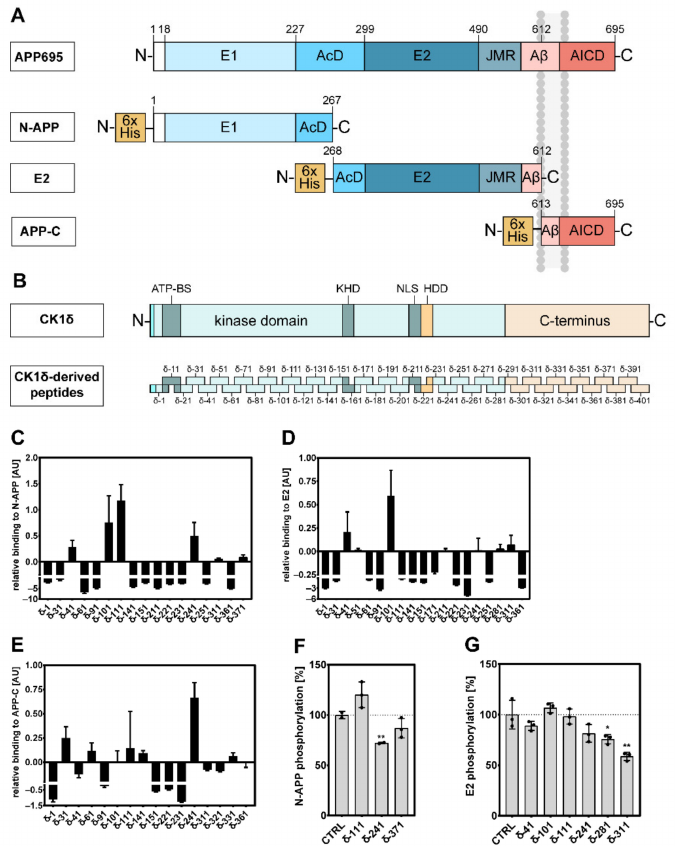
Figure 1. CK1 δ -derived peptides interact with APP695 fragments N-APP, E2, and APP-C and inhibit phosphorylation of N-APP and E2. ( A ) Domain structure of APP695 and the subsequently used protein fragments N-APP, E2, and APP- C [22]. ( B ) Domain structure of CK1 δ and localization of CK1 δ -derived peptides within in the full-length protein sequence. ( C,D,E ) Detection of CK1 δ -derived peptides specifically binding to APP695 fragments N-APP, E2, and APP-C was performed by ELISA ( n = 3). Specific binding to wells coated with APP695 fragments is demonstrated relative to unspecific binding to uncoated wells. ( F,G ) Effects of CK1 δ -derived peptides on CK1 δ -mediated phosphorylation of APP695 fragments N-APP and E2 were determined by performing in vitro kinase assays in the absence (DMSO; CTRL) or presence of 20 µ M of the indicated CK1 δ -derived peptides using GST-CK1 δ as kinase ( n = 3). Statistical analysis was performed using one-tailed t -test shown as * for p ≤ 0.05 or ** for p ≤ 0.01. AcD: acidic domain; AICD: APP intracellular domain; APP: amyloid precursor protein; ATP-BS: ATP binding site; AU: arbitrary units; CTRL: control; E1/E2: ectodomain 1/2; HDD: homodimerization domain; JMR: juxtamembrane region; KHD: kinesin homology domain; NLS: nuclear localization signal; δ : CK1 δ -derived